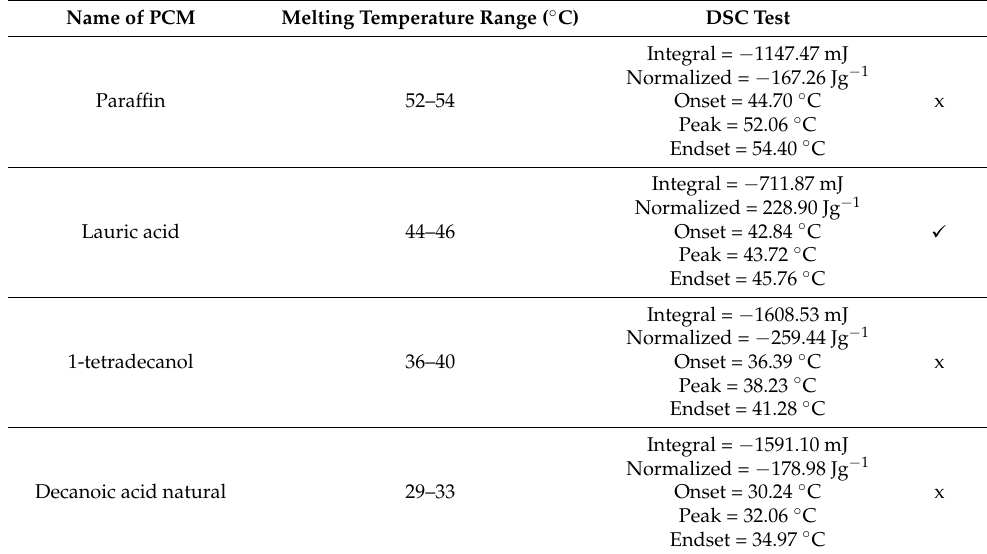
Table 1. Properties of PCMs.